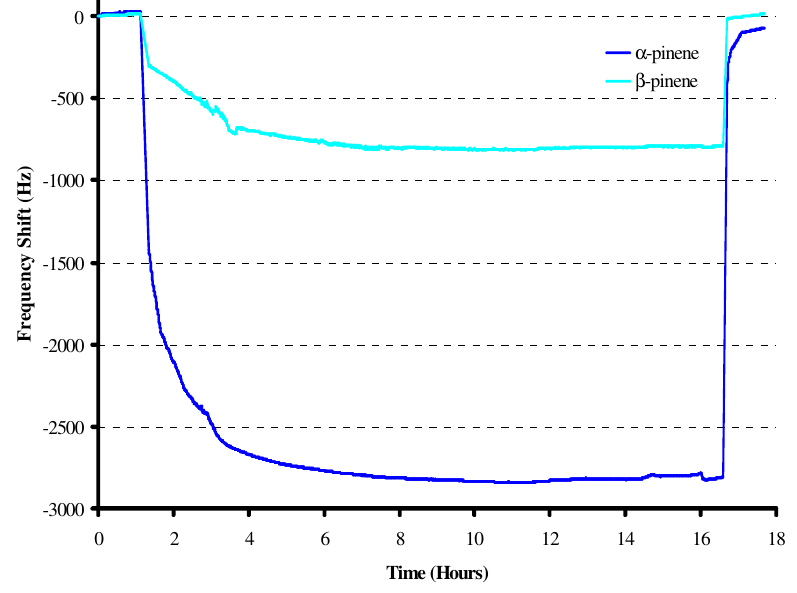
Figure 4. Emanation from fresh rosemary by MIP layers imprinted with α -pinene and β